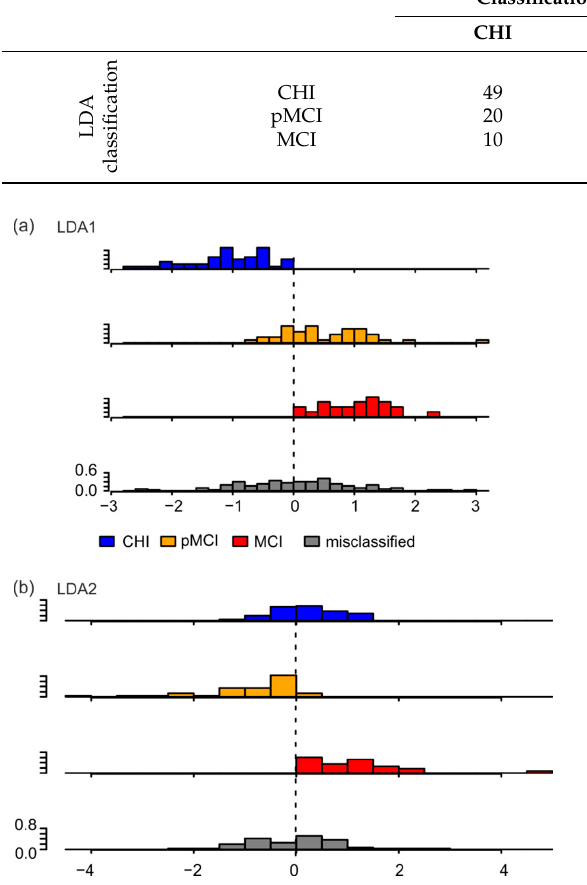
Figure 3. Histograms of probability densities of LDA values of correctly classified and misclassified participants. ( a ) LDA1; ( b ) LDA2. CHI: cognitively healthy individuals; pMCI: participants with possible mild cognitive impairments; MCI: participants with mild cognitive impairments. Table 6. Confusion matrix of classification.